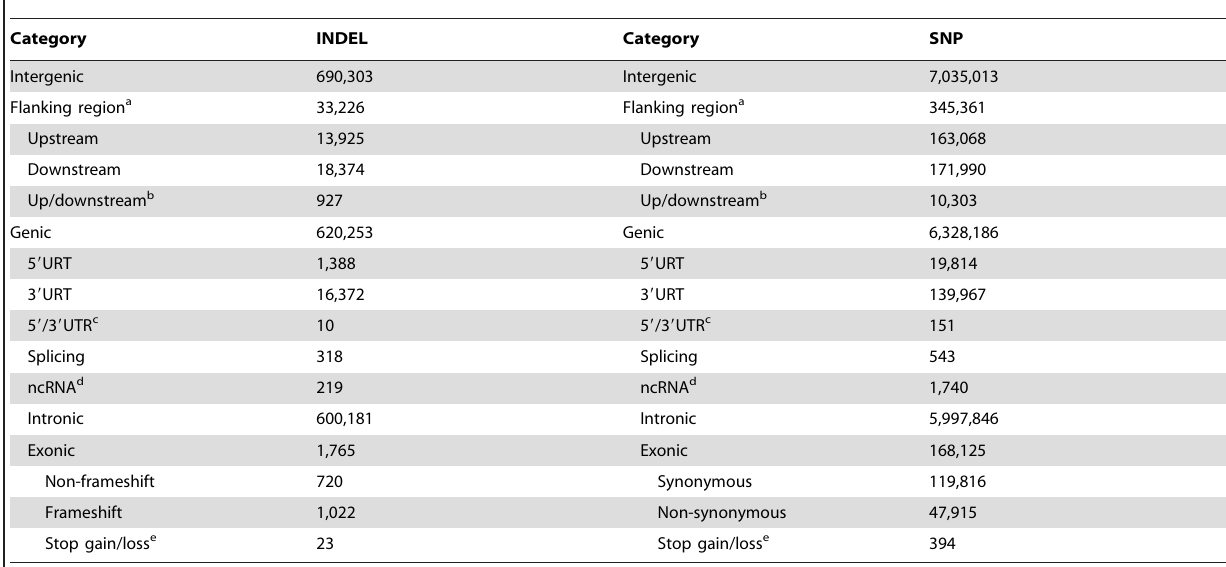
Table 3. Statistics of INDELs and SNPs in functional